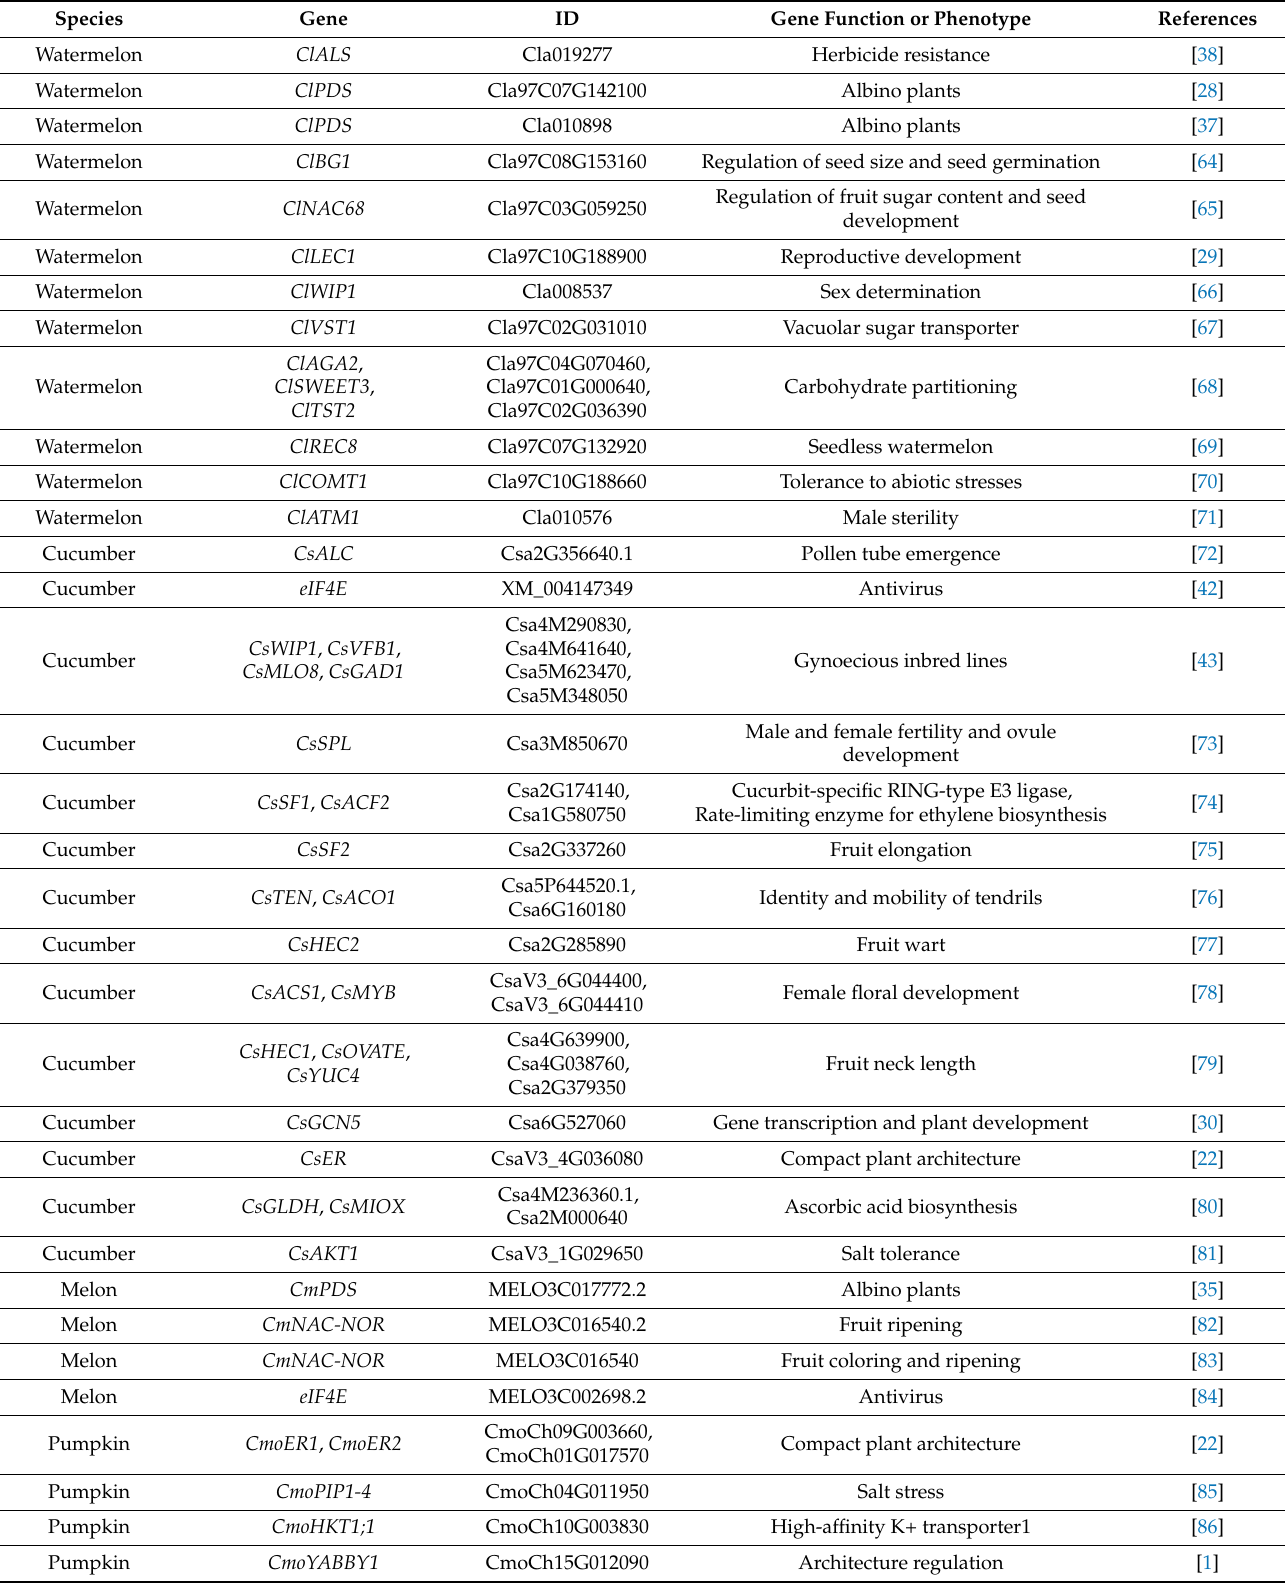
Table 2. Details of editing genes of cucurbit